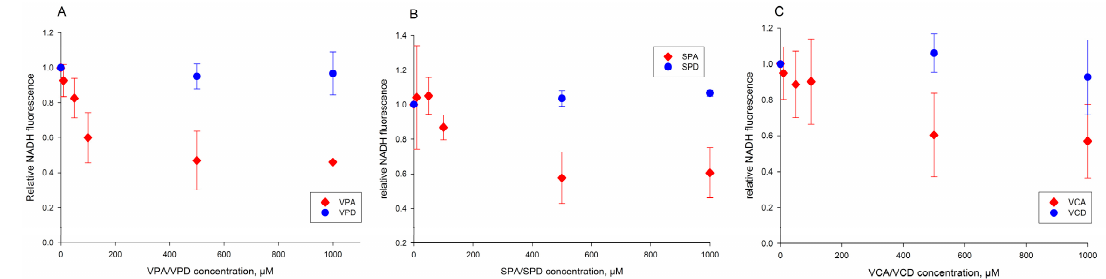
Figure 6. Dose-dependency of effects of VPA and its derivatives on pyruvate-dependent reduction of NAD(P) + by α -lipoamide dehydrogenase. ( A ) Red diamonds, VPA; blue circles, VPD. ( B ) Red diamonds, SPA; blue circles, SPD. ( C ) Red diamonds, VCA; blue circles, VCD. Experimental conditions as indicated in Figure 5. Table 1. Apparent IC 50 values of inhibition of different oxidation reactions of isolated rat liver mitochondria by VPA and its analogues.